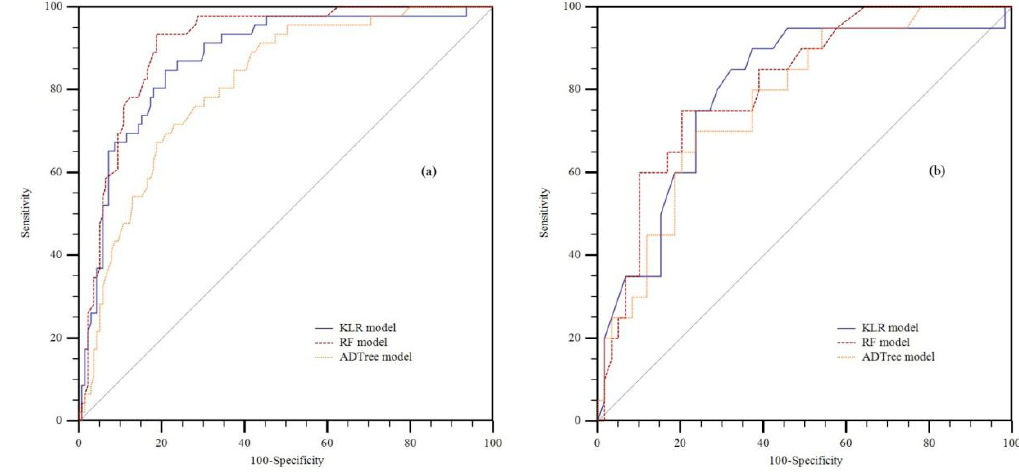
Figure 9. ROC curves of the three models using a ( a ) training dataset and ( b ) validation dataset.